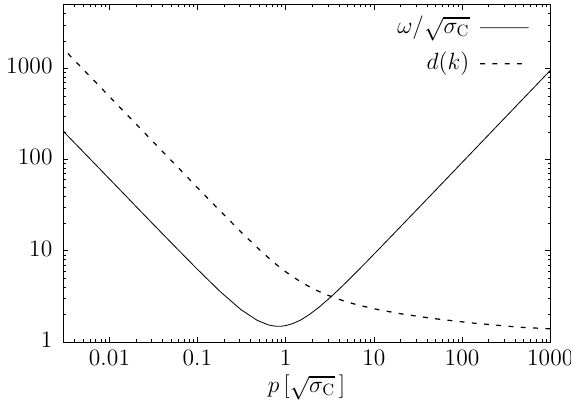
Figure 1. Numerical solution of the gluon energy (Equation (30)) ω ( k ) and the ghost form factor (32) d ( k ) .